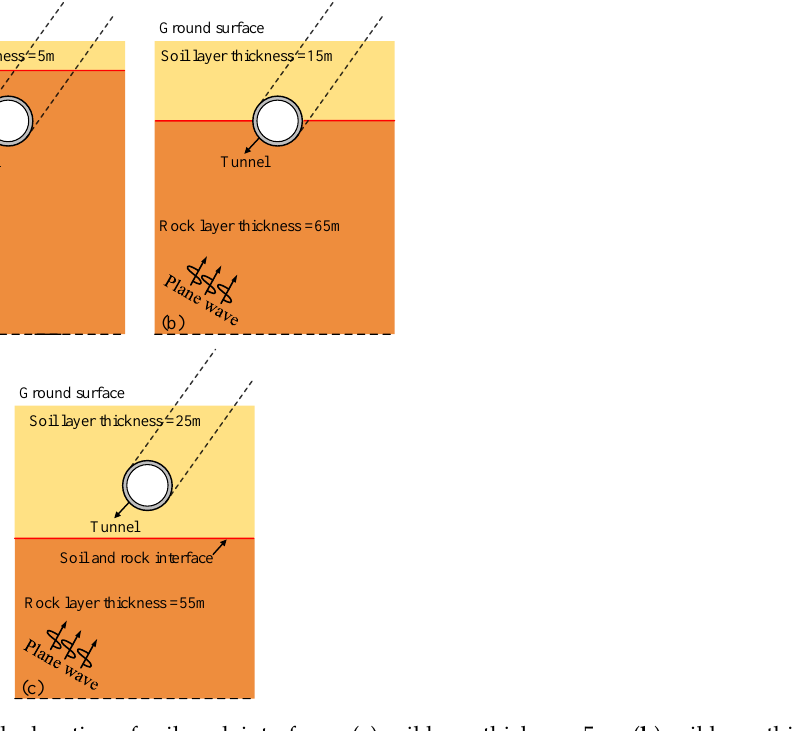
Figure 14. The location of soil–rock interfaces: ( a ) soil layer thickness 5 m, ( b ) soil layer thickness 15 m and ( c ) soil layer thickness 25 m.